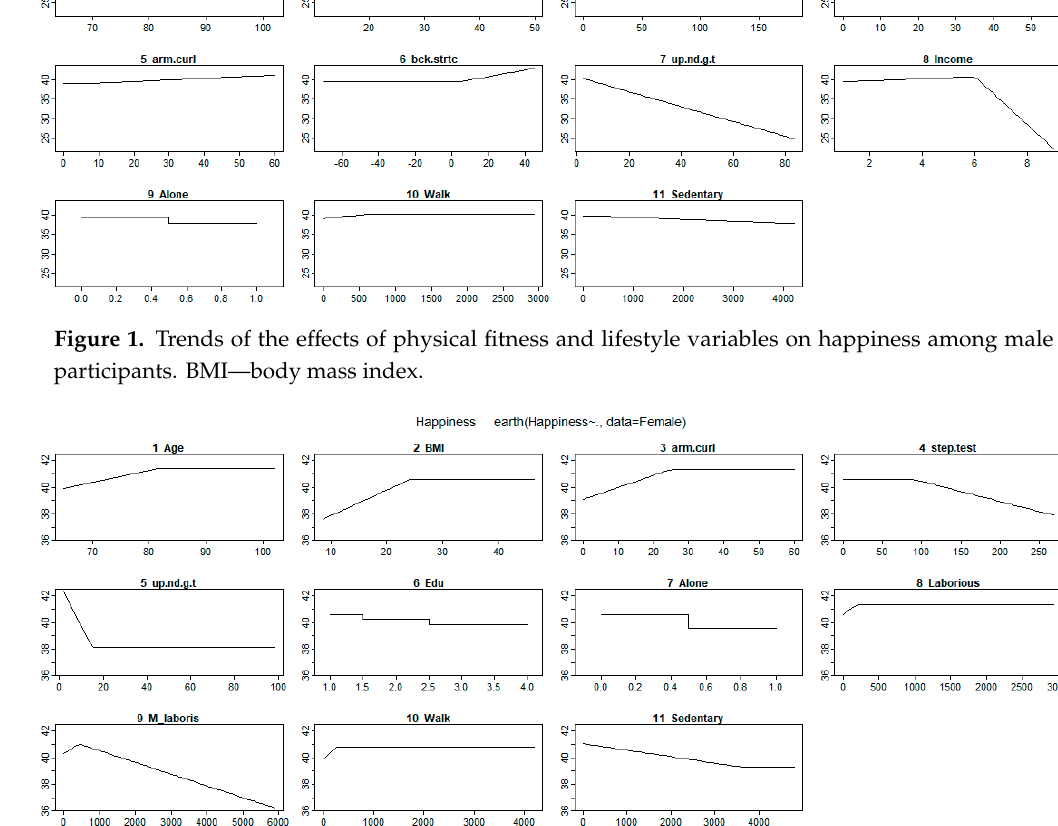
Figure 2. Trends of the effects of physical fitness and lifestyle variables on happiness among female participants. BMI—body mass index.